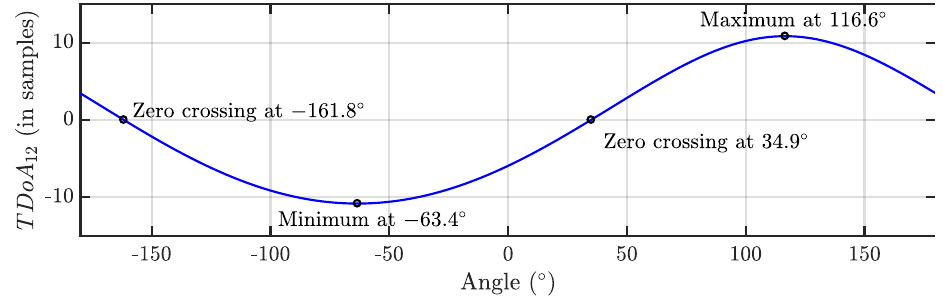
Figure 3. Periodic function representing the TDOA vs. the rotating angle. The zero-crossings correspond to the positions of the rig perpendicular to bearing of the source so the distances from the antennas to the source are the same. The maximum and minimum correspond to positions where the rig is parallel to this bearing so one of the antennas is at the farthest relative position with respect to the source and the other at the closest